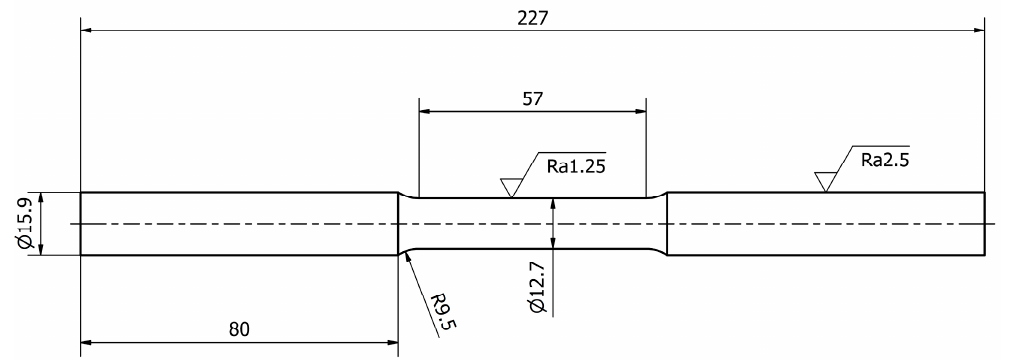
Figure 2. Mertens–Dittmann ( a ) and Seeger–Bestea ( b ) transformation based on [17].